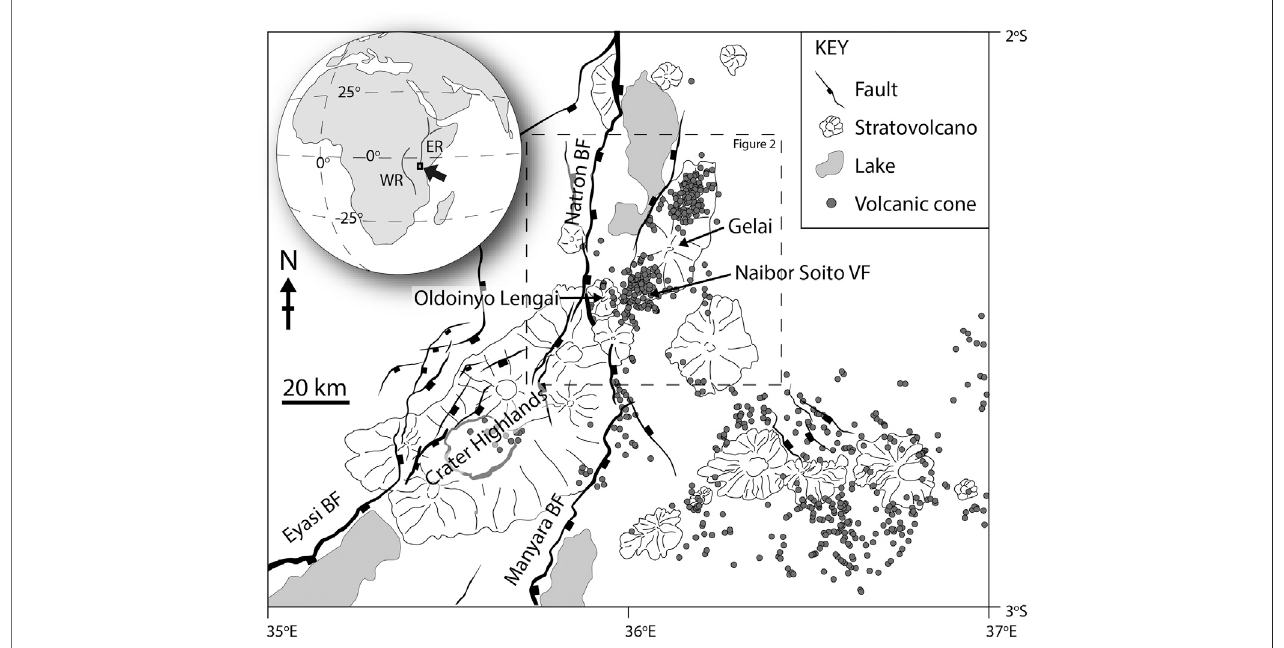
FIGURE1| Tectonicmapoftheresearchareawithvolcanoesandfaults.Thedashedlinedenotestheoutlineof Figure2 .Theinsetshowsthetwobranchesofthe East African Rift system with the rectangle denoting the research area.